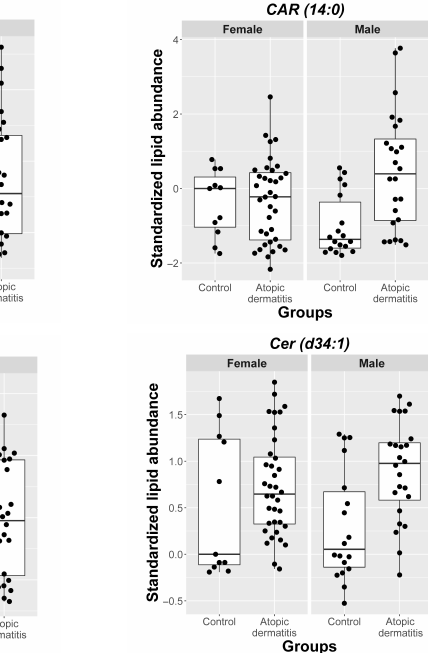
pairwise lesional and nonlesional skin samples from atopic dogs. For instance, the relative abundance of long-chain acylcarnitines was higher in lesional than in nonlesional skin, while several cholesteryl esters were reduced. The differences between the effect sizes ex- hibited in lesional and nonlesional skin are presented in Figure 4.